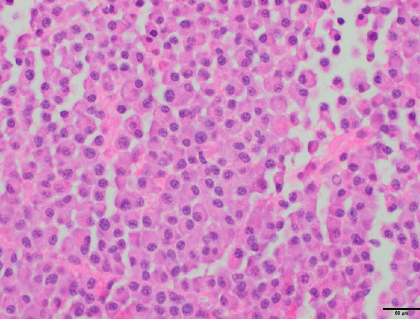
Figure 4: H&E stain of lung biopsy consistent with